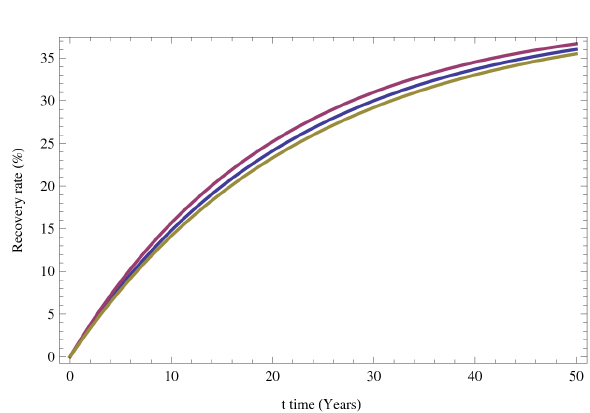
Fig. 5: Recovery rate in matrix porous medium under effect of mag- netic field